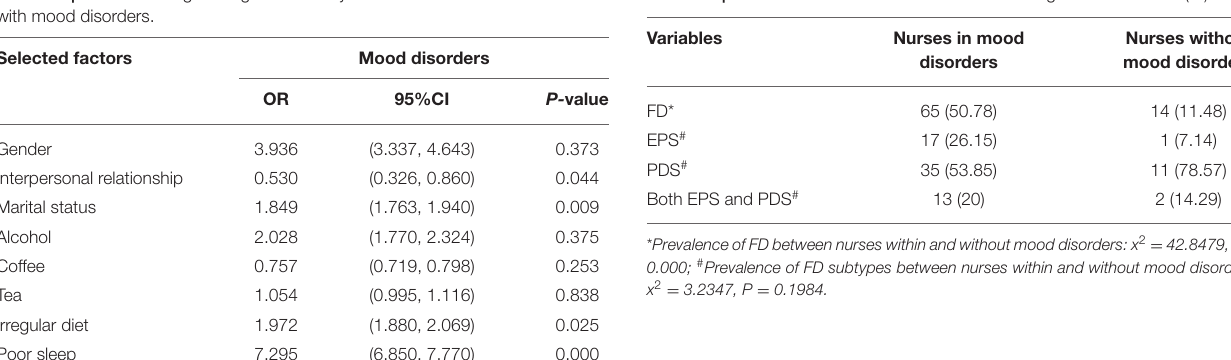
TABLE 5 | Prevalence of FD in mood disorders among neonatal nurses